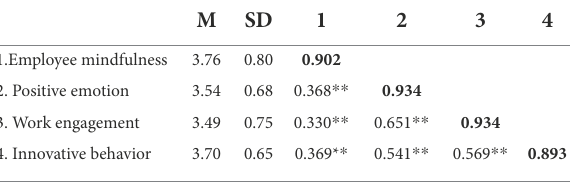
TABLE 2 Correlation coefficient, mean value, and standard deviation among